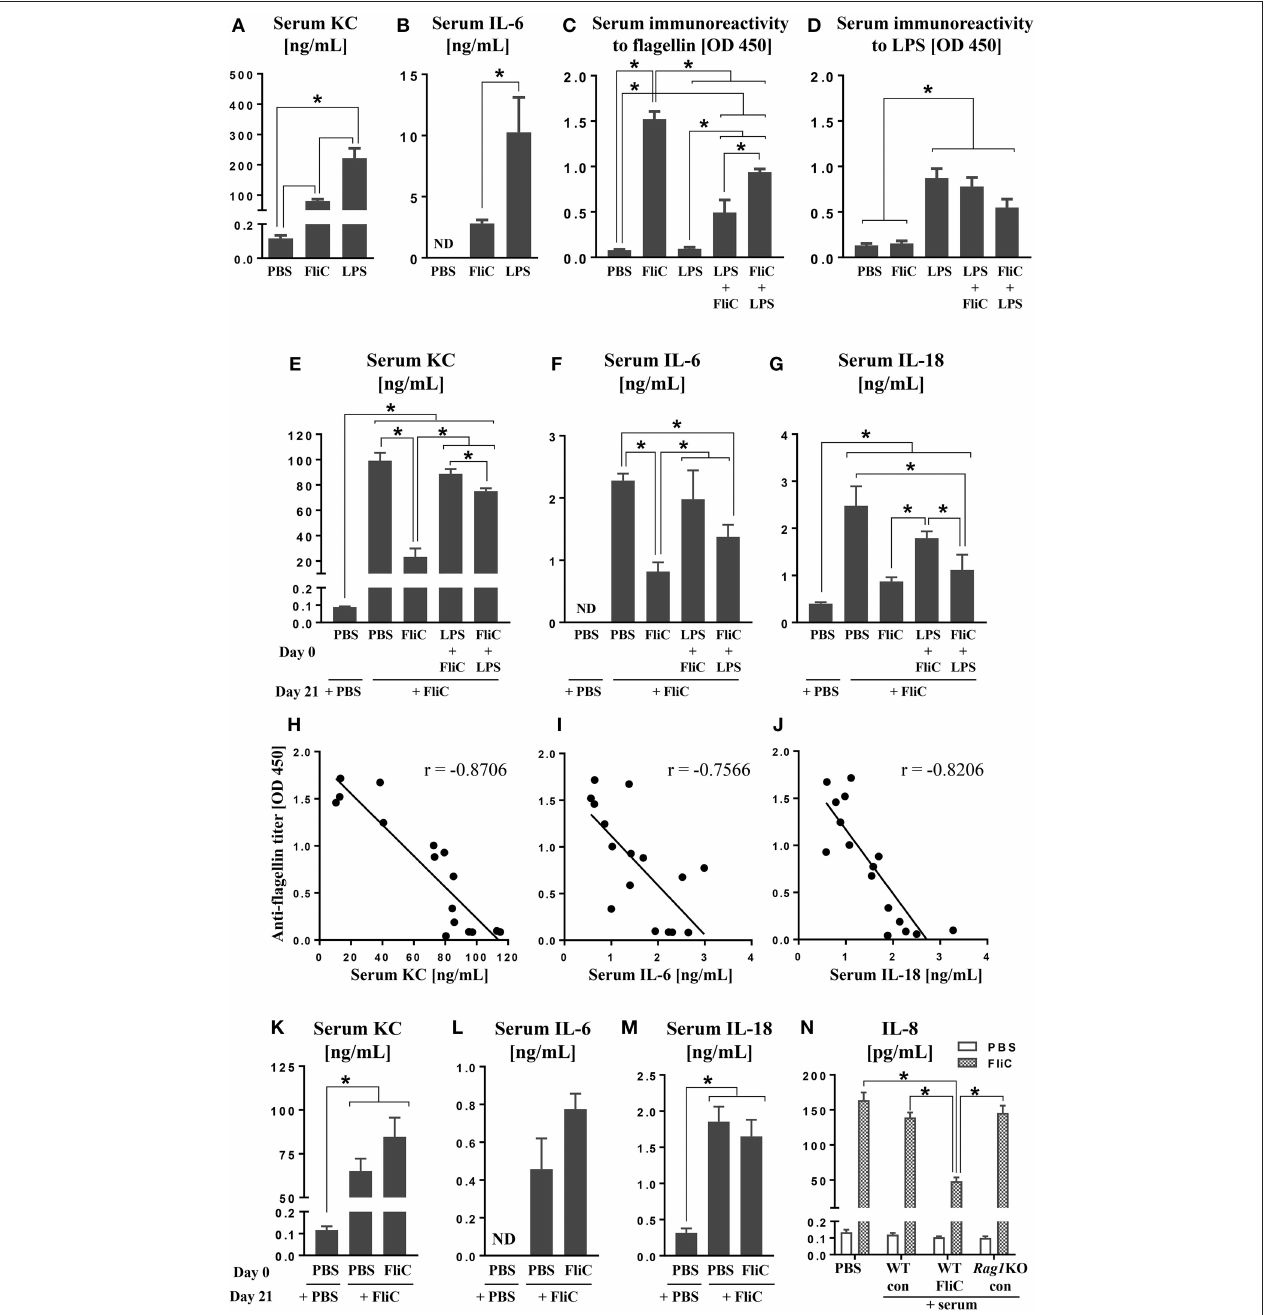
FIGURE 1 | Anti-FliC Ab attenuates TLR5 and NAIP5-NLRC4 cytokine responses to FliC re-challenge. Six week old male WT mice ( n = 4) were challenged with either PBS, LPS (10 µ g) or FliC (50 µ g). Sera were collected after 2h and analyzed for (A) KC and (B) IL-6. In another experiment, 6 week old WT mice ( n = 4) were challenged with PBS, LPS, FliC, LPS → FliC, FliC → LPS with the arrow denoting secondary challenge 3h after the initial treatment. At day 18 post-treatment, sera were collected and measured for (C) seroreactivity to flagellin and (D) seroreactivity to LPS. At day 21 post-treatment, the mice were re-challenged with FliC (50 µ g). Sera were collected after 2h and analyzed for (E) KC, (F) IL-6, and (G) IL-18. Correlations between seroreactivity to FliC against serum (H) KC [Spearman correlation ( r = − 0.8706; p (two-tailed) < 0.0001)], (I) IL-6 ( r = − 0.7566; p = 0.0007), (J) IL-18 ( r = − 0.8206; p = 0.0002). Six week old male Rag1 KO mice ( n = 4) were pre-treated with either PBS or FliC (50 µ g) at day 0. At day 21, mice were challenged with FliC. Sera were collected 2h post-treatment and analyzed for (K) KC, (L) IL-6, and (M) IL-18. HT29 cells were co-treated with FliC and serum from either FliC-treated WT, naïve WT, or FliC-treated Rag1 KO mice. (N) Five-hour culture supernatants were assayed for secretion of IL-8. Results presented as mean ± SEM and are representative of two independent experiments. ND, not detected. Data in (H–J) were analyzed with Spearman correlation test. All other data were analyzed via ANOVA with post-hoc Tukey’s test with * p < 0.05.